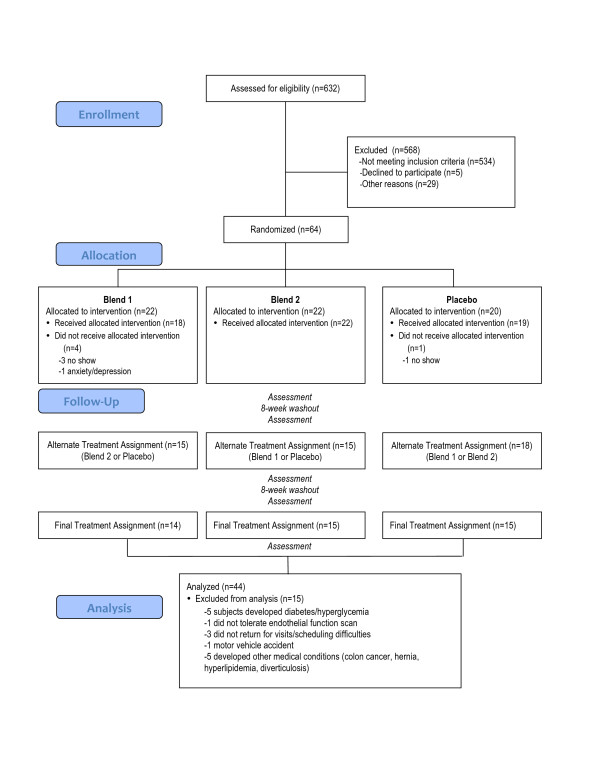
Flow of participants in the trial.